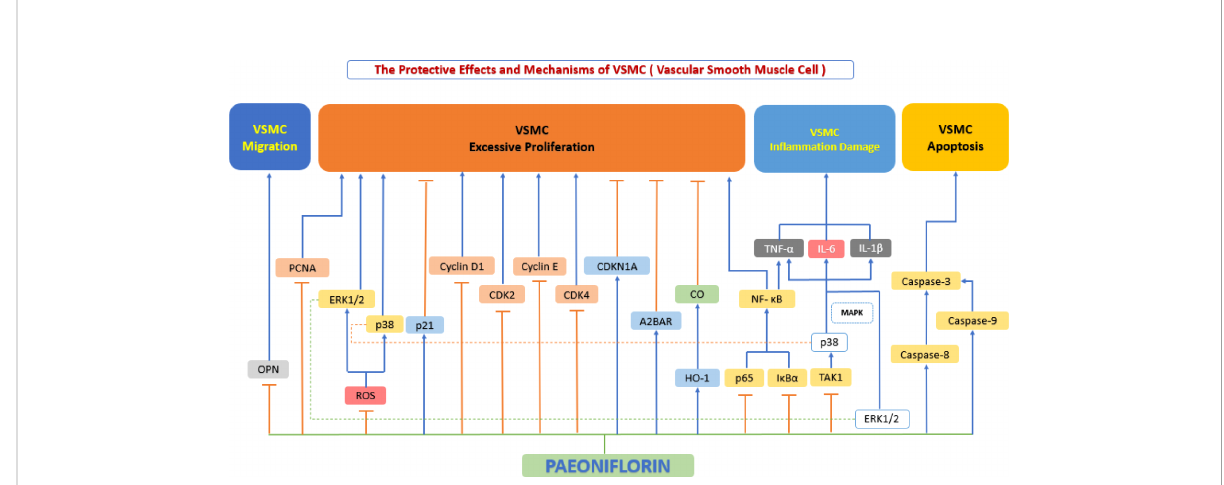
FIGURE 6 The protective effects and mechanisms of paeoni fl orin on smooth muscle cells. Paeoni fl orin prevents vascular smooth muscle cell (VSMC) dysfunction by inhibiting excessive VSMC migration and excessive proliferation, suppressing in fl ammatory factor secretion, and regulating VSMC survival, this in turn exerts an anti-atherosclerotic effect. CDK2, cyclin-dependent kinase 2; CDK4, cyclin-dependent kinase 4; CDKN1A, cyclin- dependent kinase inhibitor 1A; CO, carbonic oxide; ERK1/2, extracellular signal-regulated kinase 1/2; HO-1, Heme Oxygenase 1; IL-1 b , interleukin 1 b ; IL-6, interleukin 6; I k B a , inhibitor of kappa B alpha; MAPK, mitogen-activated protein kinase; NF- k B, the nuclear factor-kB; OPN, osteopontin; p38, p38 mitogen-activated protein kinase (MAPK); PCNA, proliferating cell nuclear antigen; ROS, reactive oxygen species; TAK1, transforming growth factor beta-activated kinase1; TNF- a , tumor necrosis factor a